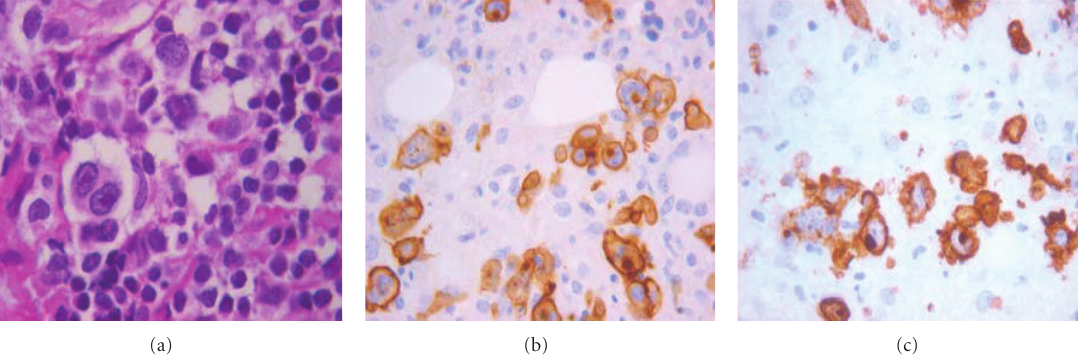
Figure 2: Reed-Sternberg cell (a) seen in a cellular background rich in lymphocytes of a classical Hodgkin’s lymphoma. Immunohistochem- ical expression of the activation markers CD30 (b) and CD15